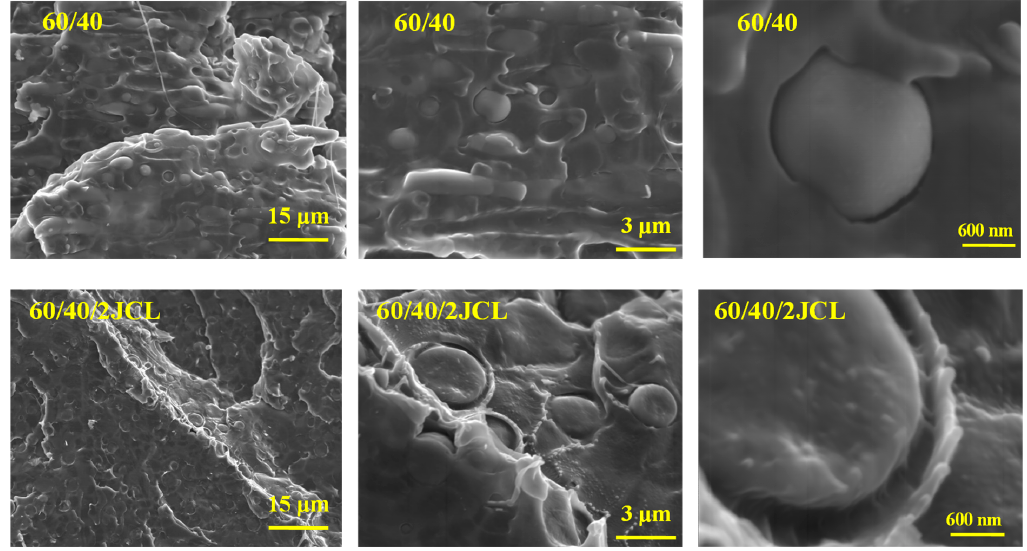
Figure 2. SEM images of the cryogenic fractured surfaces of the 60MB/40,